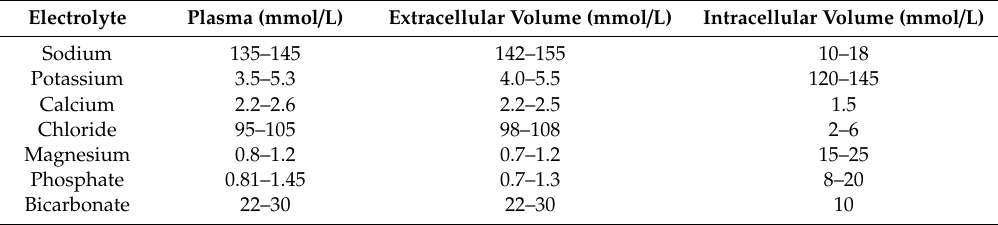
Table 1. Electrolyte concentrations in the human body